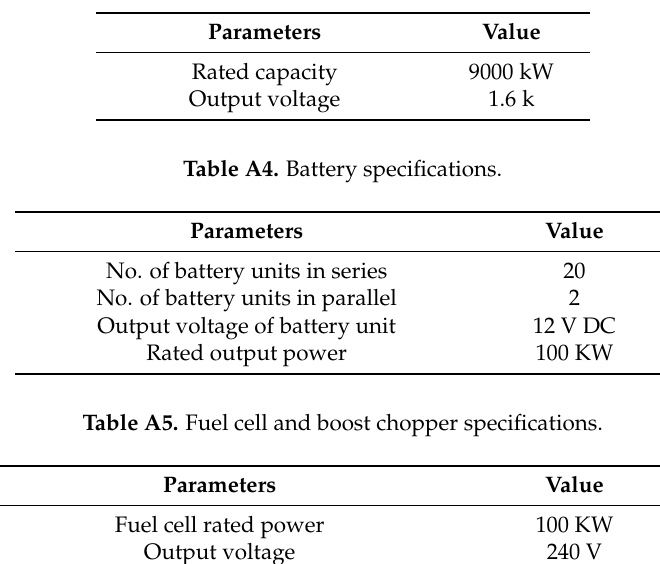
Table A3. Wind turbine specifications.